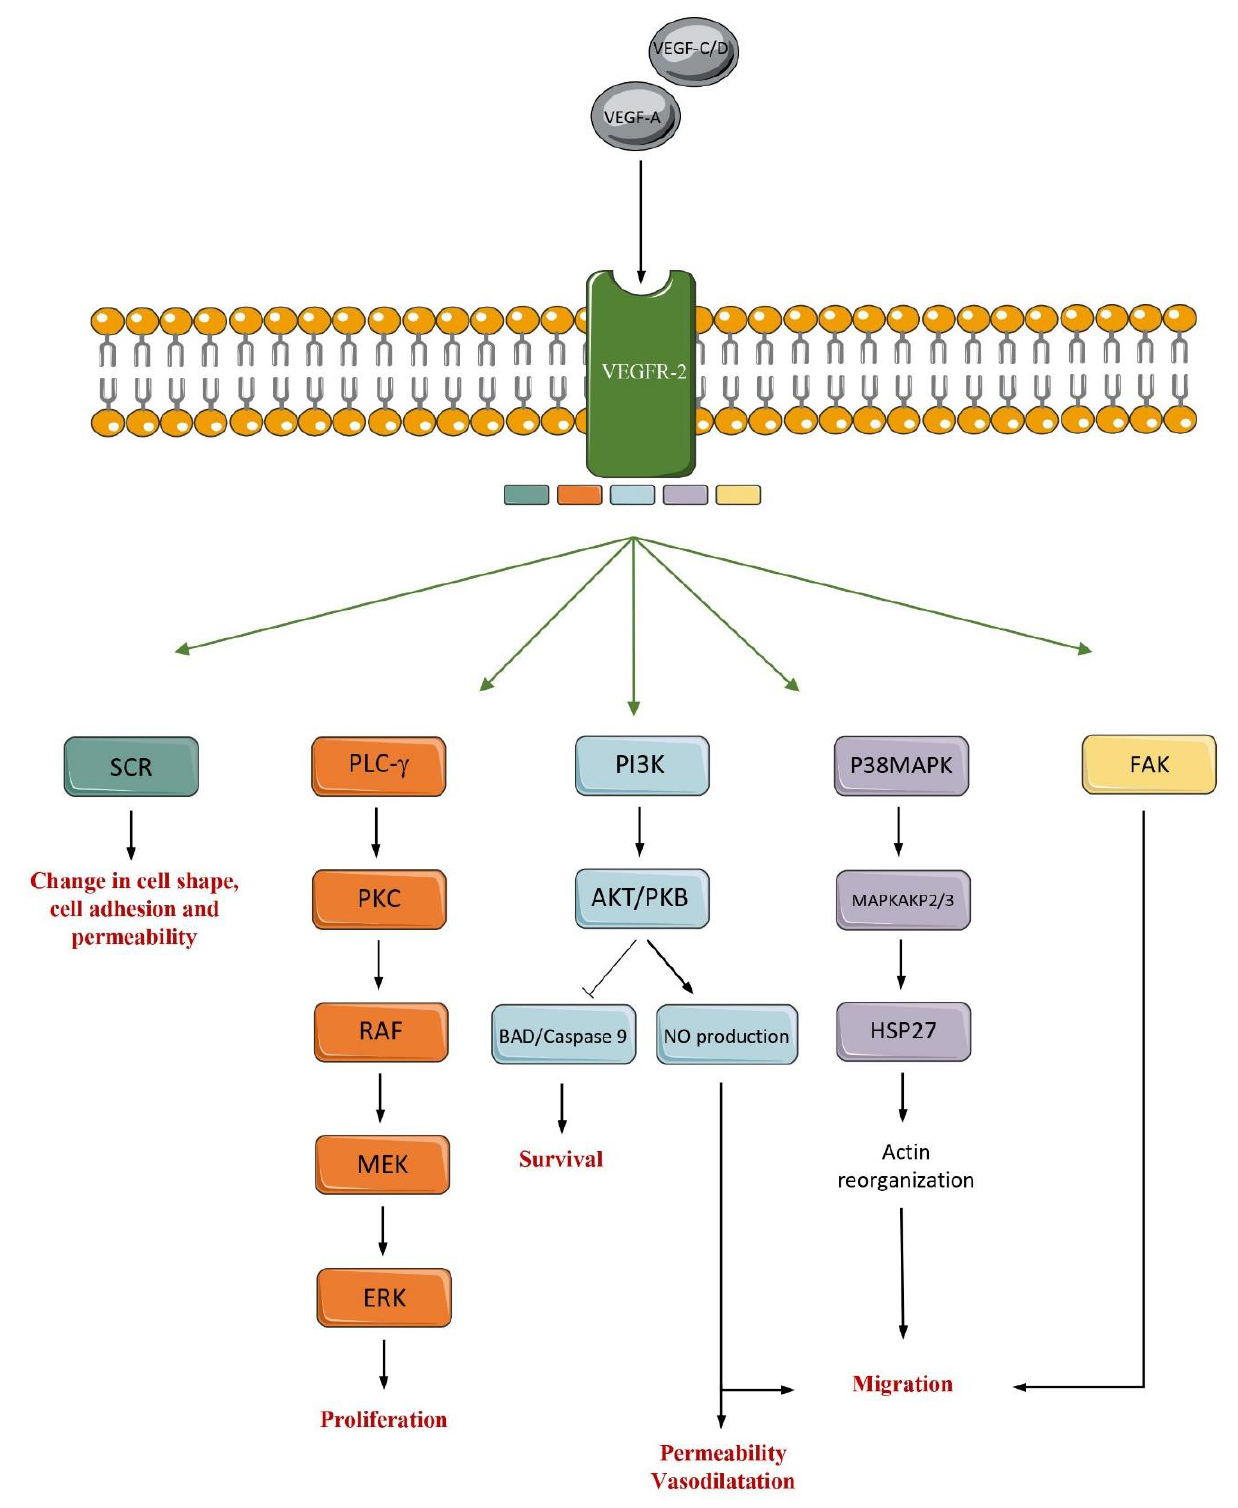
Figure 2. The VEGFR2 signaling pathways in endothelial cells. The VEGFR2 signaling pathways are induced by the bind- ing of VEGF-C, VEGF-E and VEGF-A to VEGFR2. The binding of ligand to VEGFR2 can result in the activation of different pathways such as SCR, PLC-y, PI3K, P38MAPK and FAK. These different pathways control cell shape, cell adhesion and permeability, proliferation, survival, permeability, vasodilatation, and